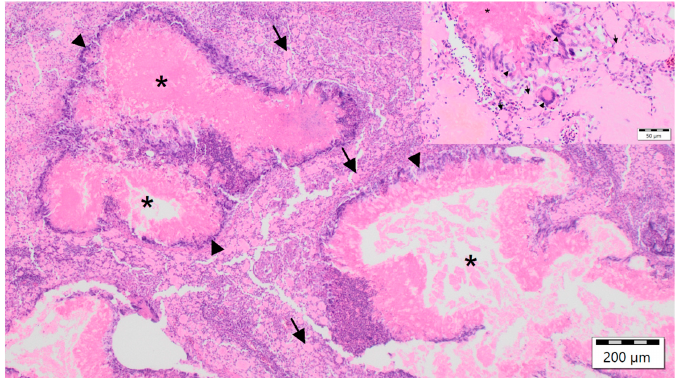
Figure 3. Micrograph of a subcutaneous fascial nodular mass from a Red-crowned Parakeet ( Cyanoramphus novaezelandiae ) labelled as case no. 1, characterized by diffuse foamy and cholesterol- laden macrophages (black arrows), multifocal fibrinous granulomas with central necrosis and fibrin (black asterisk), surrounded by multinucleated giant cells (black arrowheads), histiocytes, lymphocytes and heterophils. Haematoxylin and eosin staining, 100x magnification and inlay 400x magnification.